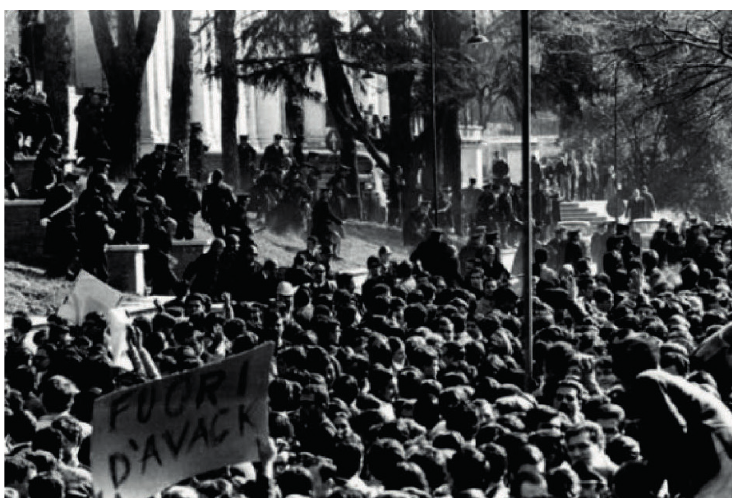
confine (Milano, 2008)